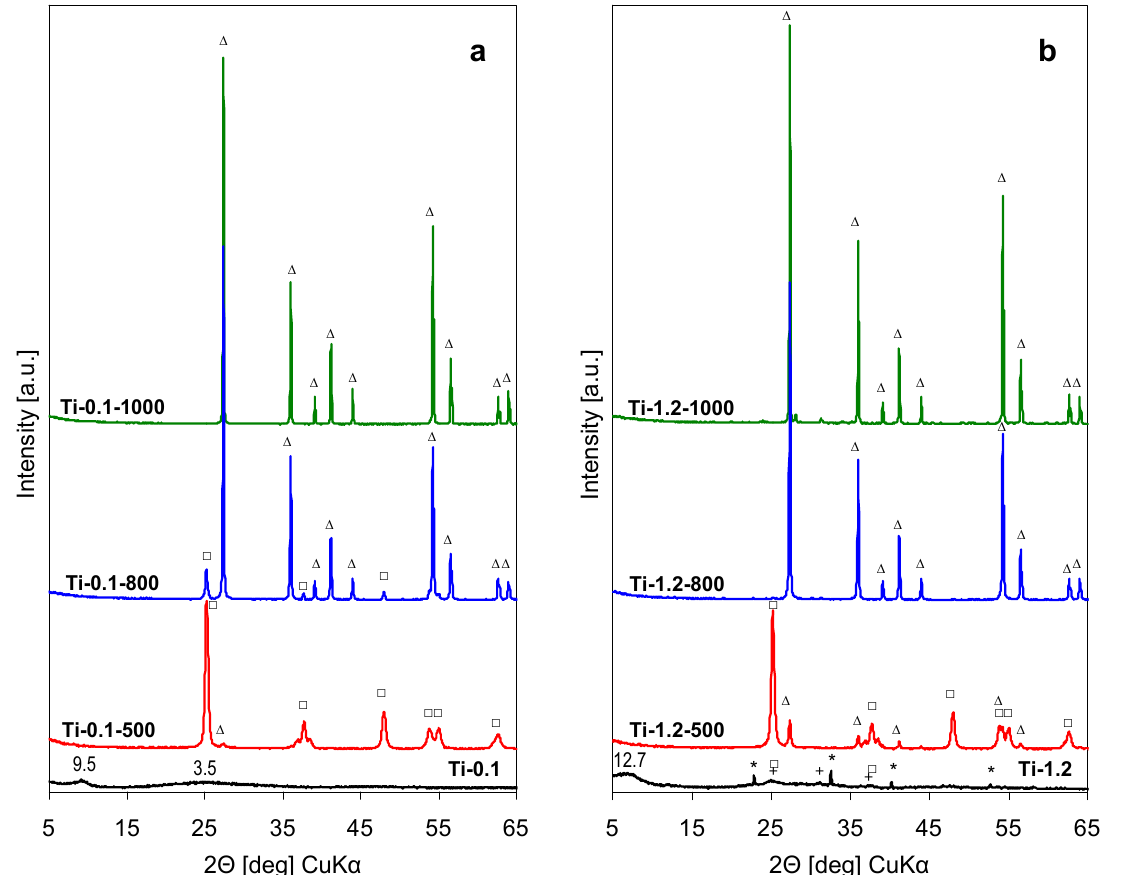
Figure 1. Powder X-ray diffraction (XRD) patterns illustrating the effect of thermal treatment on hydrolysates obtained by lyophilization of Ti-pillaring solution: ( a ) As received at pH = 0.1, ( b ) after pH adjustment to 1.2 ( (cid:3) anatase, ∆ rutile, + brookite, * NH 4